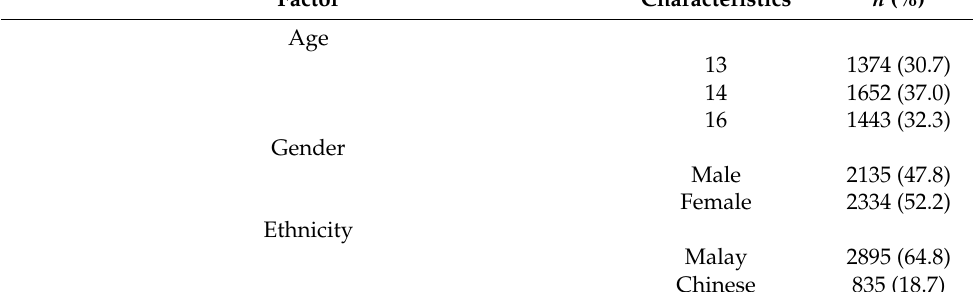
Table 1. Distribution of individual factors ( n = 4469). Factor